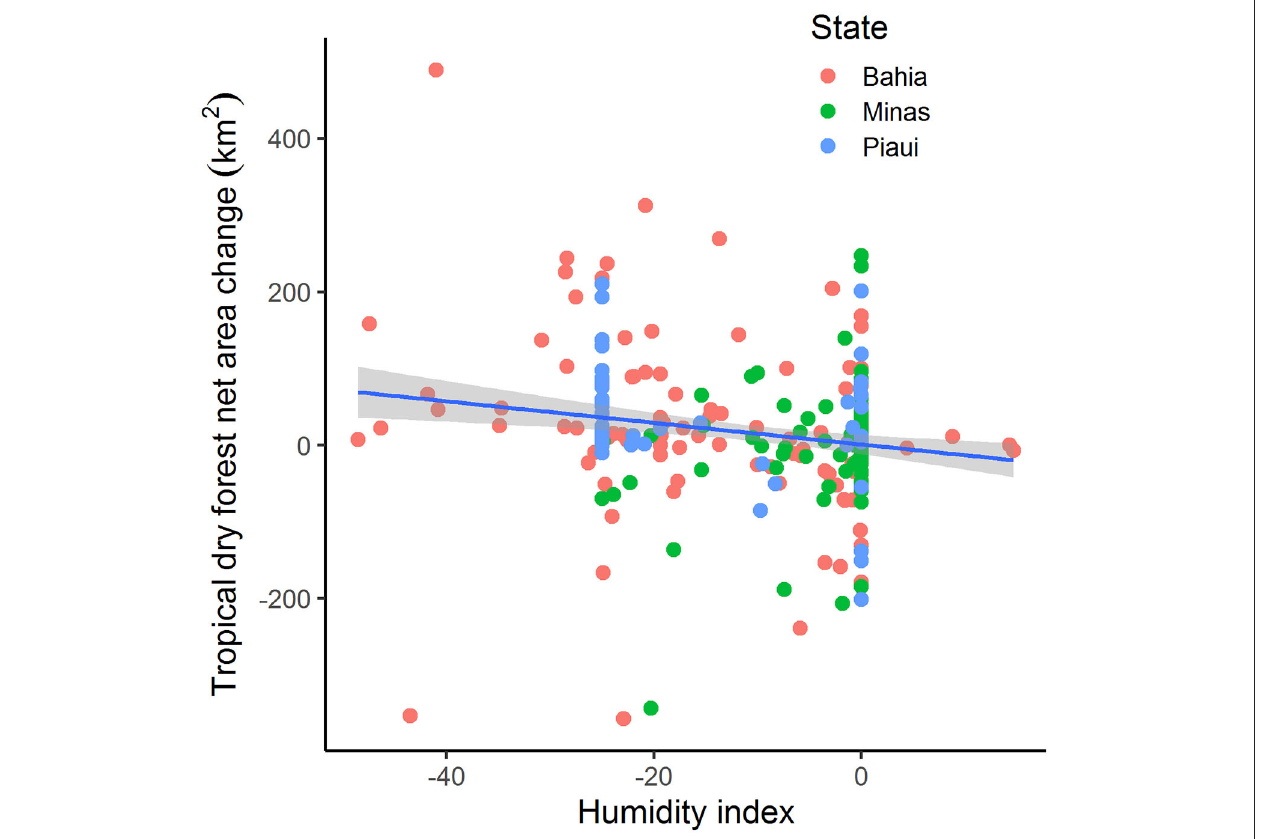
FIGURE 6 | Effects of the humidity index on the net change in tropical dry forest (TDF) area for three Brazilian states. This was the only explanatory variable retained in the minimal adequate generalized linear model with a Gaussian error distribution (adjusted R 2 = 0.50, p < 0.05) after stepwise model selection ( n = 294). Positive values indicate net area gain (natural regeneration) whereas negative values indicate net area loss (deforestation) at county level between 2007 and 2016. Circles represent values obtained after summation of raw residuals with the predict values for each variable, assuming average values for other covariates. Partial model parameters: Y = 3.468 – 1.146*humidity, R 2 = 0.027). Additional parameters for complete and minimal adequate models are given in Supplementary Table 3